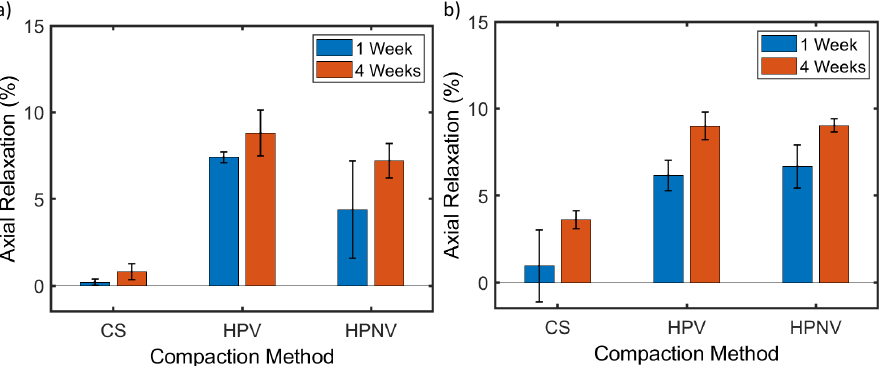
Figure 8. Axial relaxation for ( a ) HDPE1 and ( b ) HDPE2 pellets compacted at 159 MPa. Three compaction methods were used: hydraulic press with a vacuum (HPV) and without a vacuum (HPNV) as well as a compaction simulator (CS). Values plotted are the mean with the error bars depicting ± one standard deviation ( n =